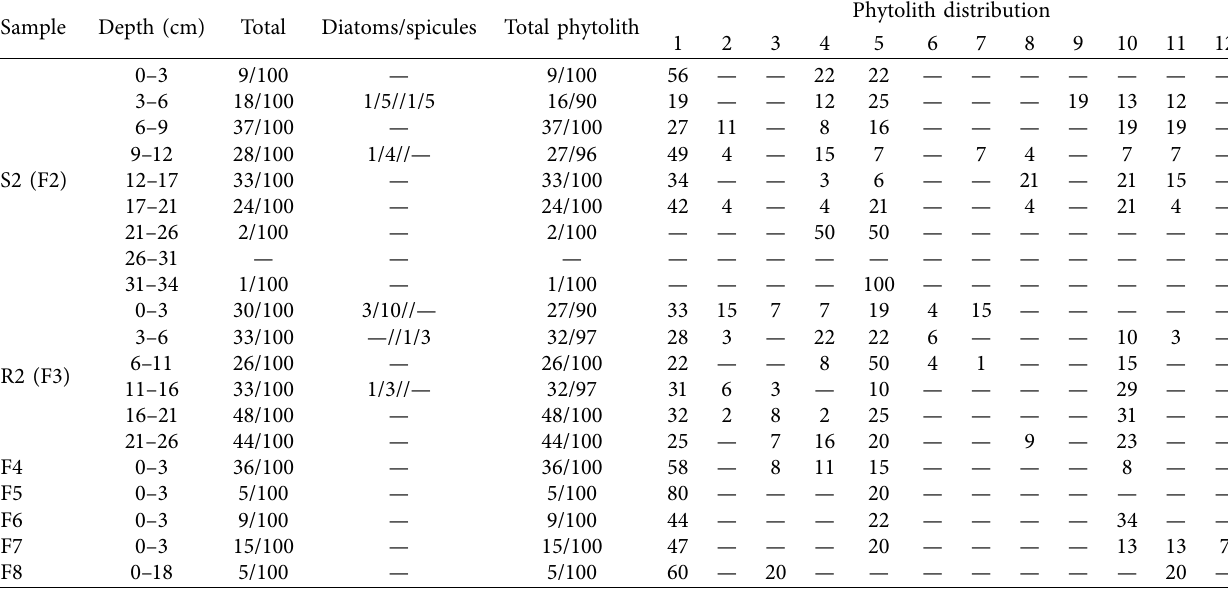
1: herbs; 2: indicator types of coniferous species; 3: trichomes of grasses of forest habitats; 4: trichomes of grasses of meadow-type habitats; 5: short sells of grasses of steppe-type habitats; 6: dendritic firms, indicator of cereals; 7: reed; 8: indicator forms of grasses of arid-type habitats; 9: trichomes of grasses of ruderal habitats; 10: indicator forms of Artemisia; 11: mosses; 12: unknown and fragmented